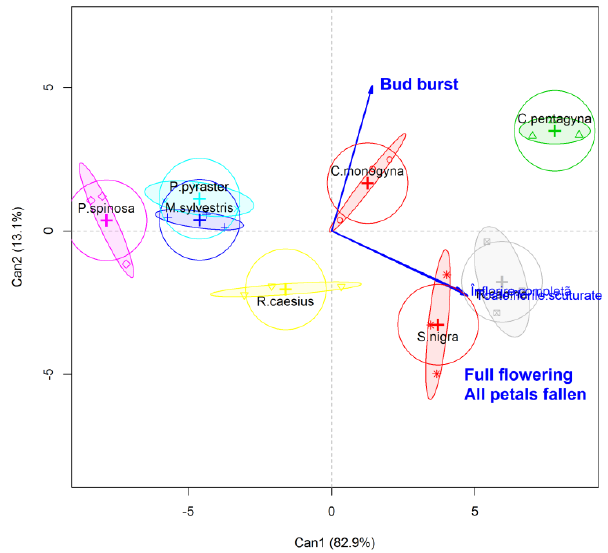
Figure 3. Canonical distribution of